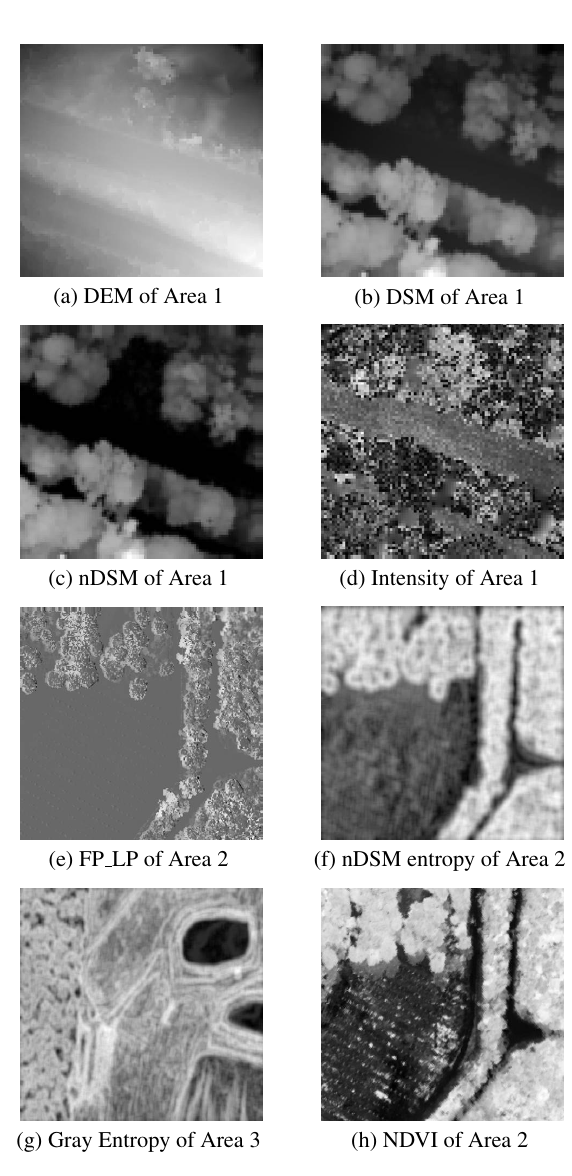
Figure 4. Eight different features extracted from each area nature of classification we want to apply. After training, a knowl-